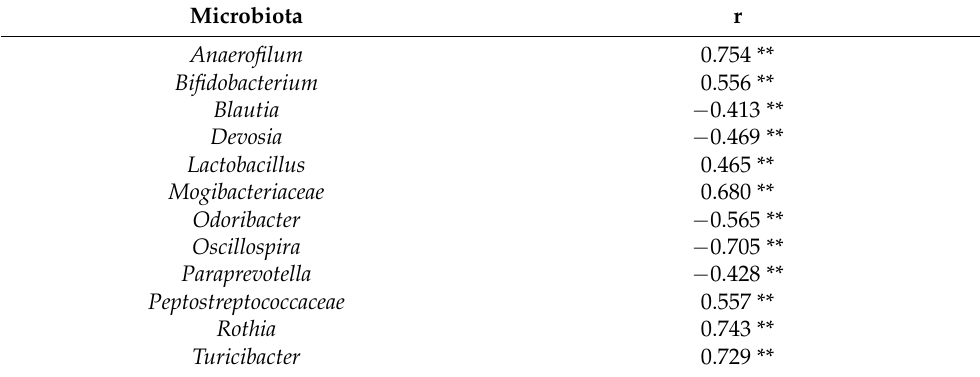
Figure 10. PCoA plot ( A ), phylum abundance ( B ), class abundance ( C ), and general heatmap ( D ) of gut microbiota in feces of normal group, model group, and differently treated groups. Table 5. Pearson correlation coefficients between gut microbiota and anti-osteoporosis